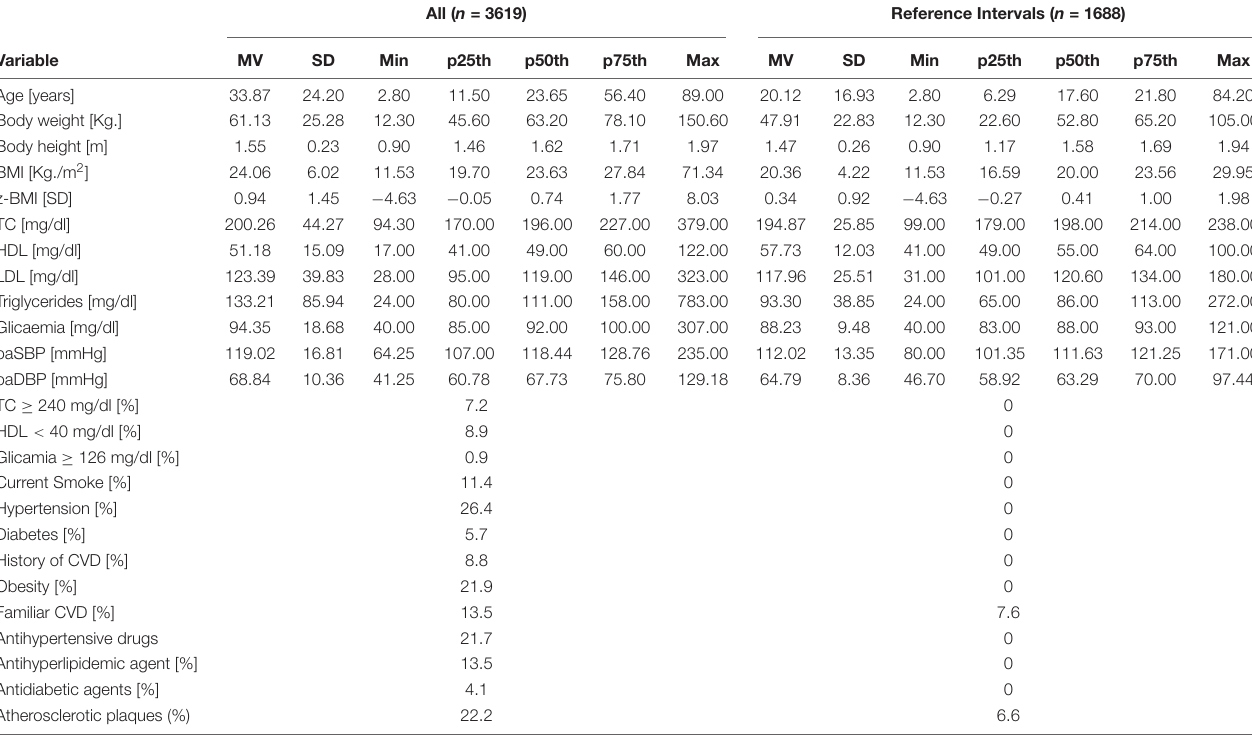
TABLE 1 | Subjects demographic, anthropometric, and clinical characteristics.